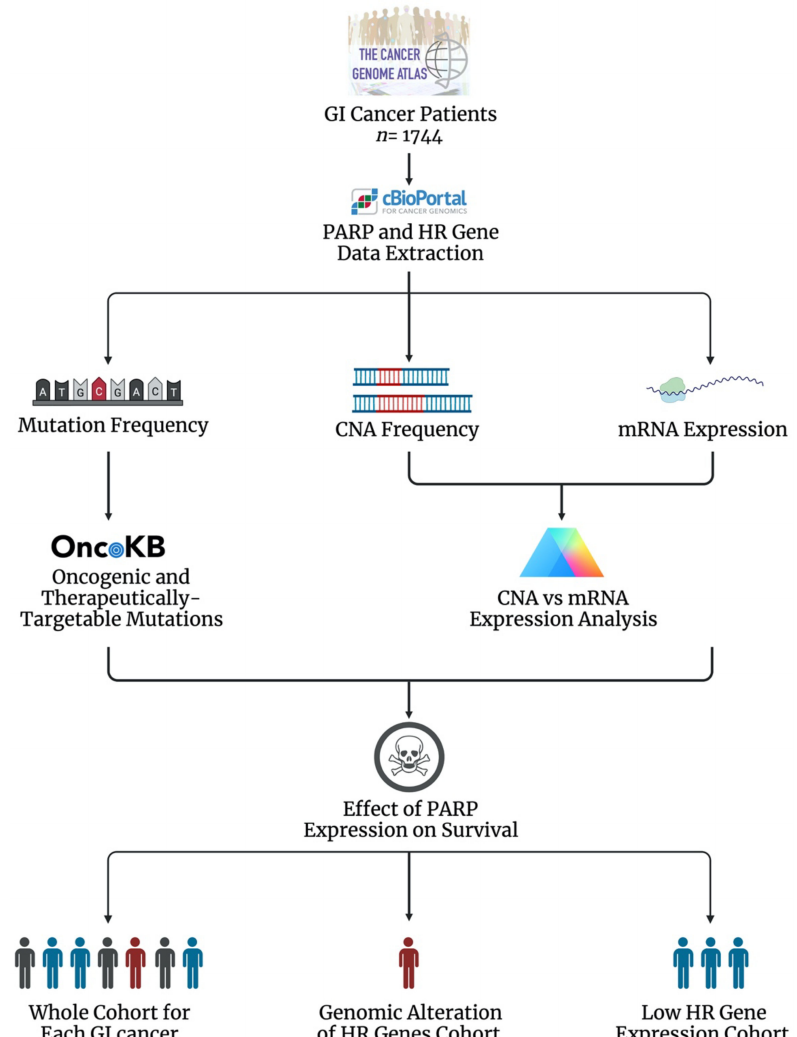
Figure 2. Workflow diagram of data collection and analysis